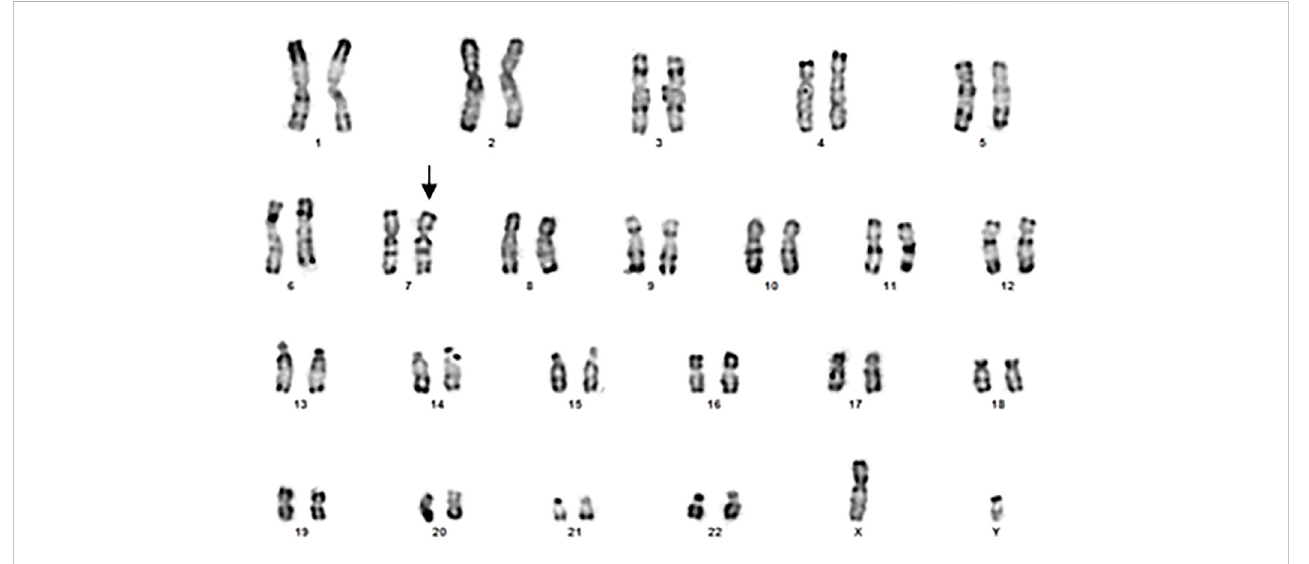
FIGURE 1 Banding cytogenetics of the patient in favor of a derivative of chromosome 7 (arrow).